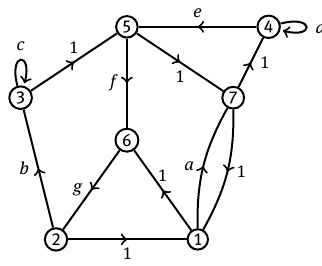
Figure 2: Digraph for the first exceptional pattern found by Algorithm